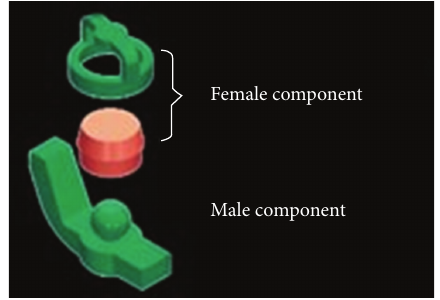
Figure 10: The RHEIN 83 OT CAP attachments